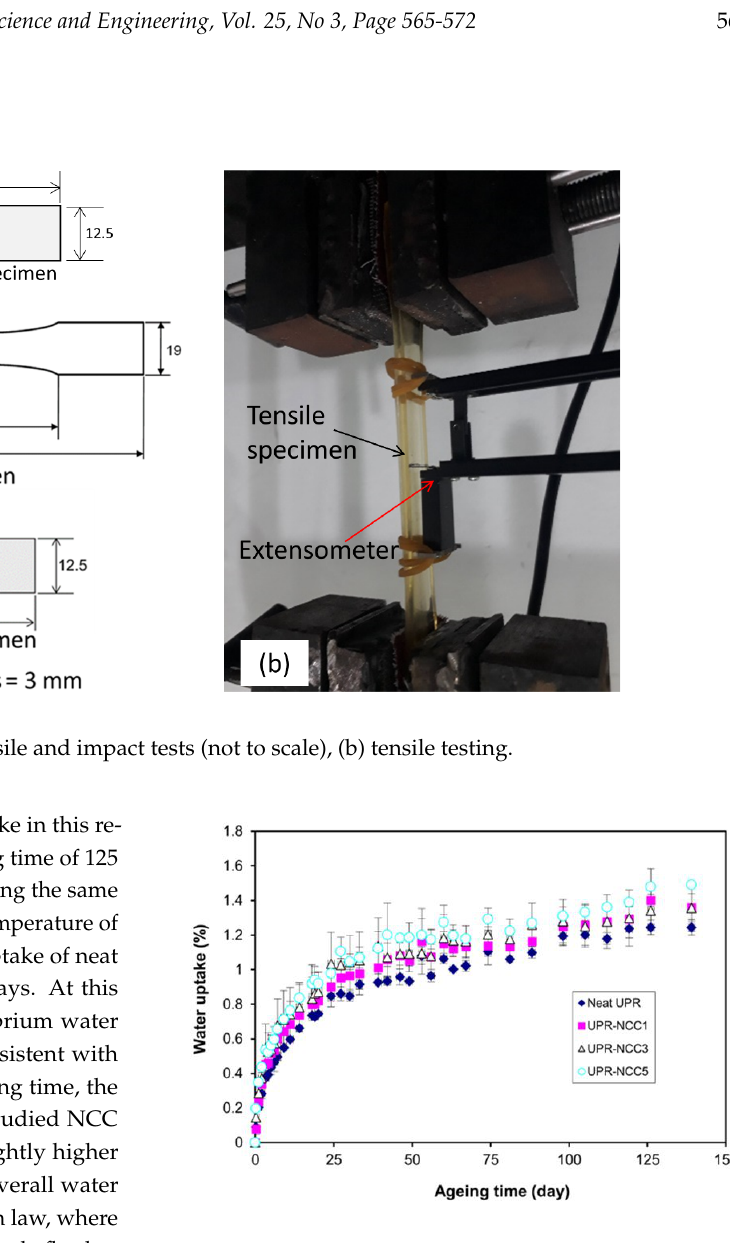
Fig. 2. Water uptake vs ageing time curves of NCC/UPR